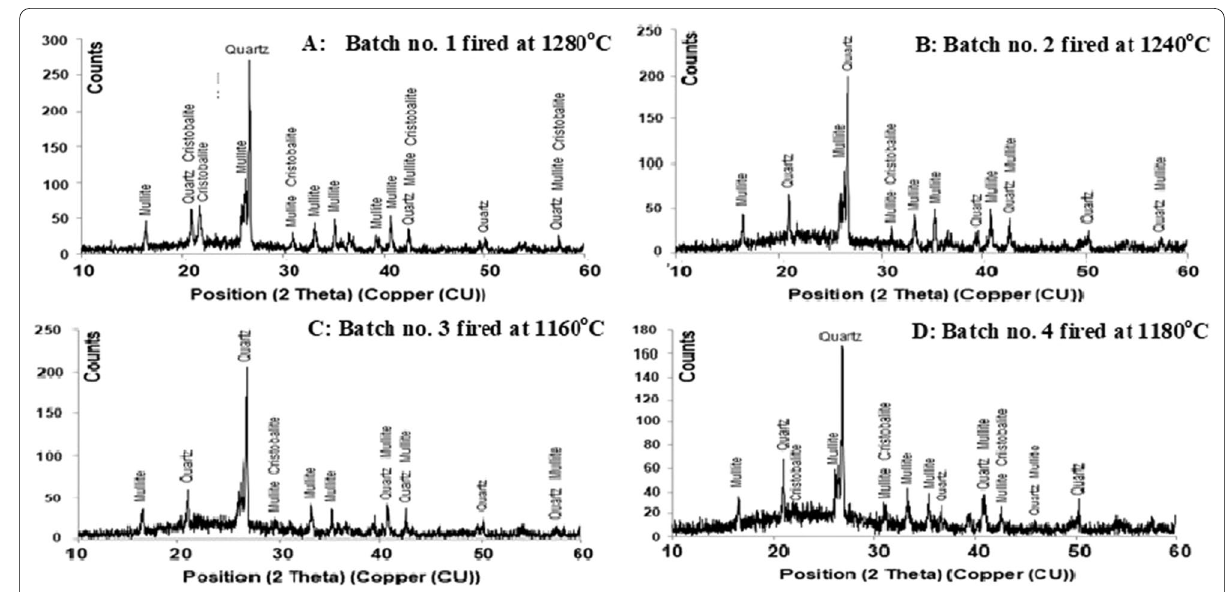
Fig. 7 XRD patterns of the fired